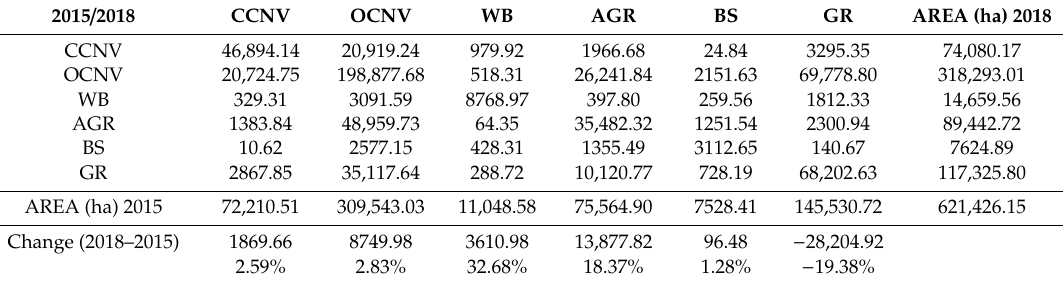
Table 9. Land cover change matrix relative to the period 2015–2018. CCNV—close canopy natural vegetation; OCNV—open canopy natural vegetation; WB—water bodies; AGR—agriculture; BS—bare soils;